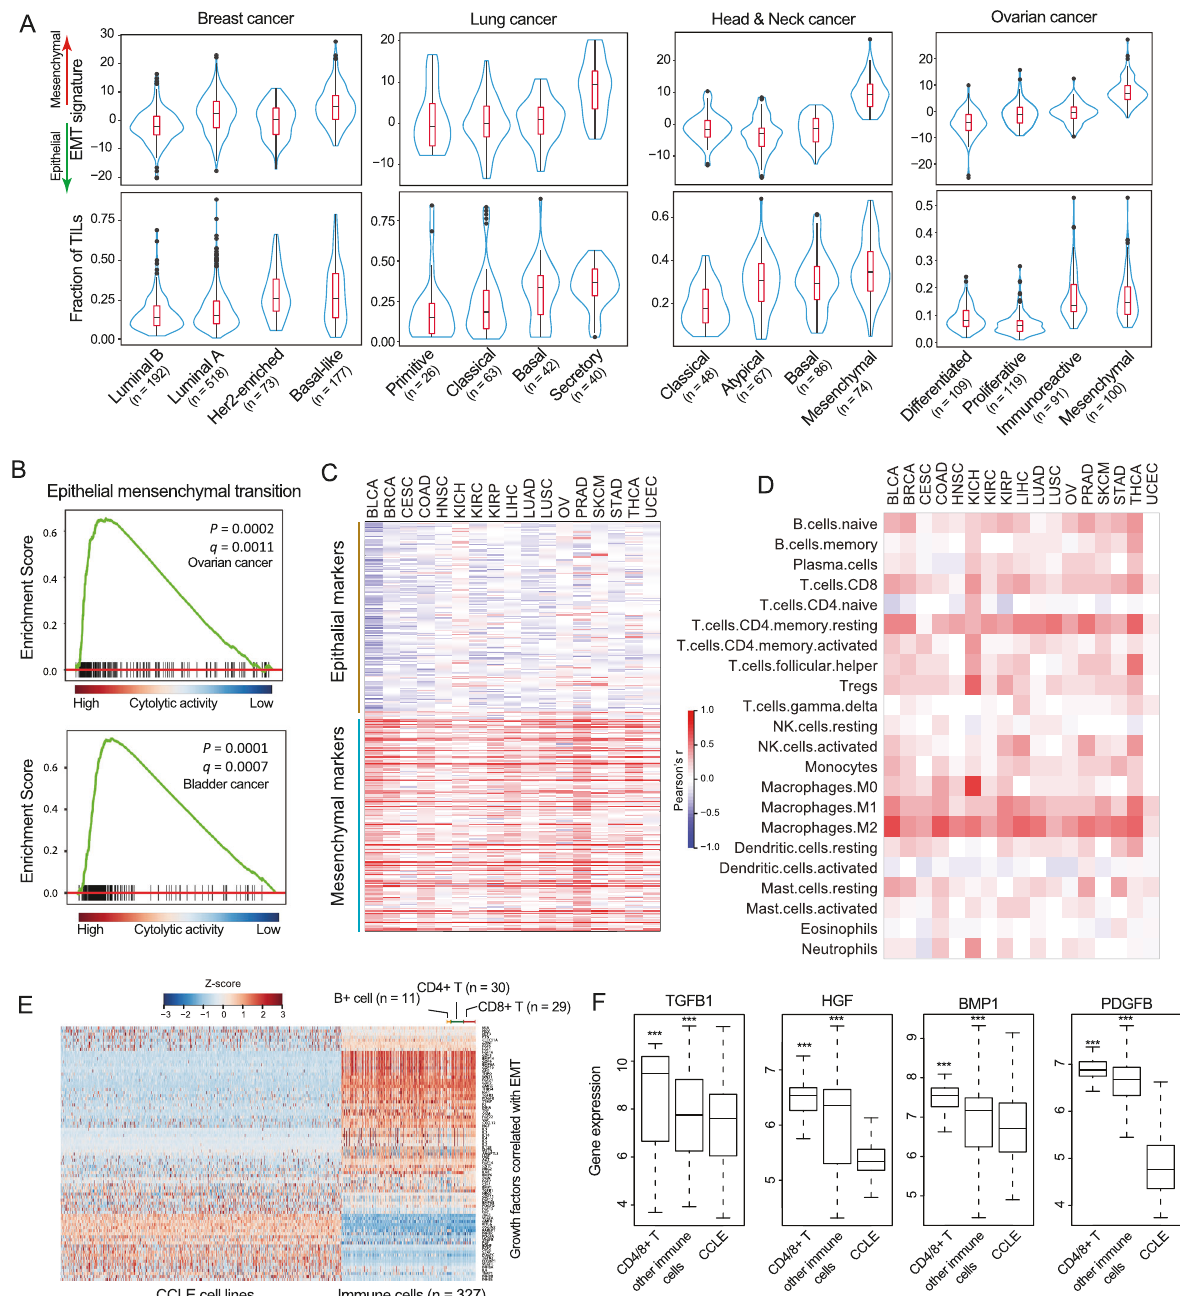
Fig. 1 Pan-cancer landscapes of crosstalk between EMT and immune evasion across 17 types of solid cancer. A Violin plots of the in fi ltration levels of TILs and EMT levels for different subtypes of four types of cancer. B Gene set enrichment analysis of CYT high and CYT low tumors in ovarian cancer and bladder cancer. C Correlation between expression of mesenchymal and epithelial marker genes and CYT across the different types of cancer. D Correlation between the in fi ltration levels of the 22 immune cell subpopulations and EMT scores across different types of cancer. E Expression heatmaps of 83 EMT-associated growth factors in cancer cell lines and immune cell lines. F Boxplots of expression of TGFB1 , HGF , BMP1 and PDGFB in different cell groups. *** P < 0.001. CYT cytolytic activity, EMT epithelial-mesenchymal transition, TILs tumor-in fi ltrating